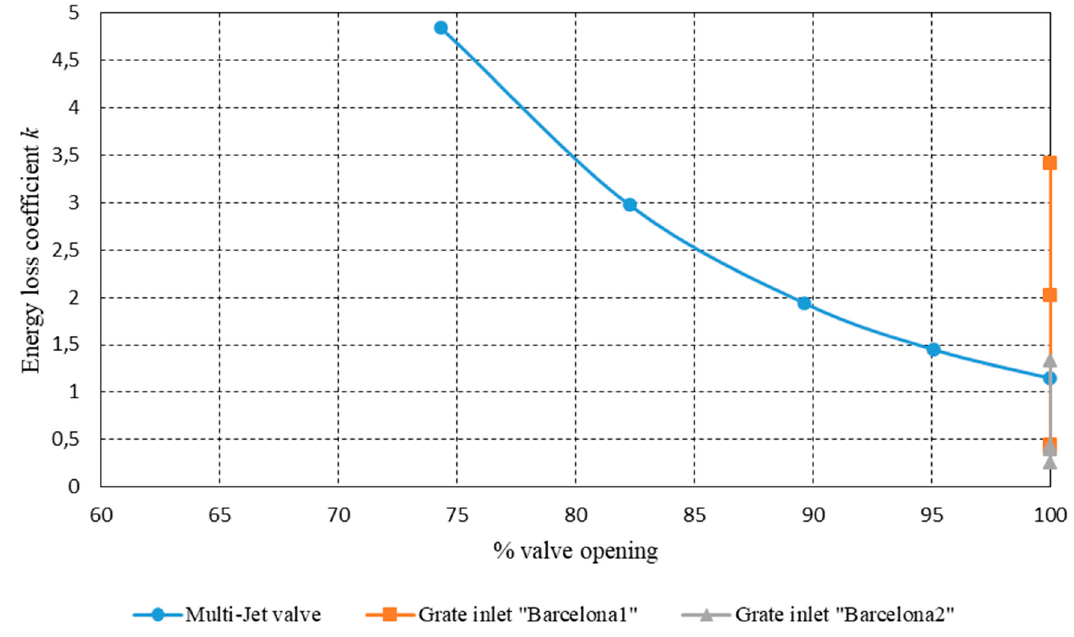
Figure 10. Energy loss coe ffi cient vs. % valve opening for a multi-jet valve